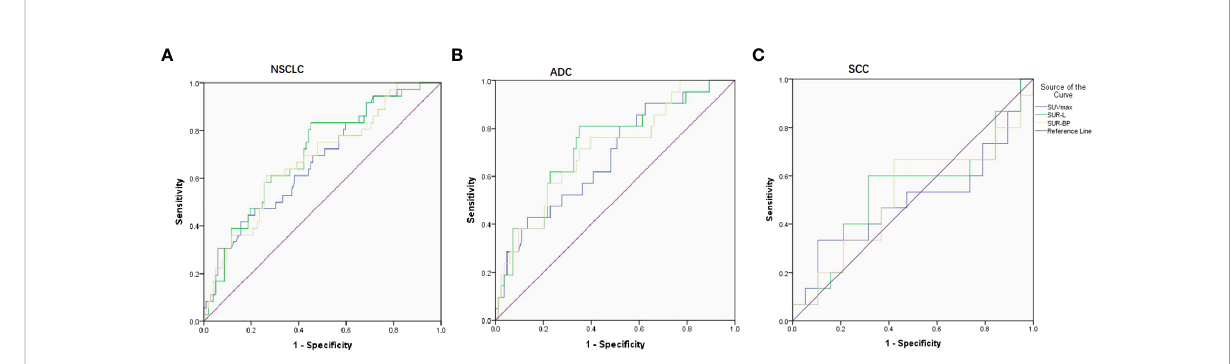
FIGURE 1 ROC curve on predicting PD-L1 expression based on three parameters (SUVmax, SUR-L, and SUR-BP). (A) In NSCLC patients, the cutoff value was 17.86, 4.84, and 8.98 with AUC being 0.671, 0.702, and 0.678, respectively. (B) In ADC patients, the cutoff value was 17.05, 4.96, and 7.30 with AUC being 0.682, 0.727, and 0.710, respectively. (C) In SCC patients, there were no differences with AUC being 0.498, 0.533, and